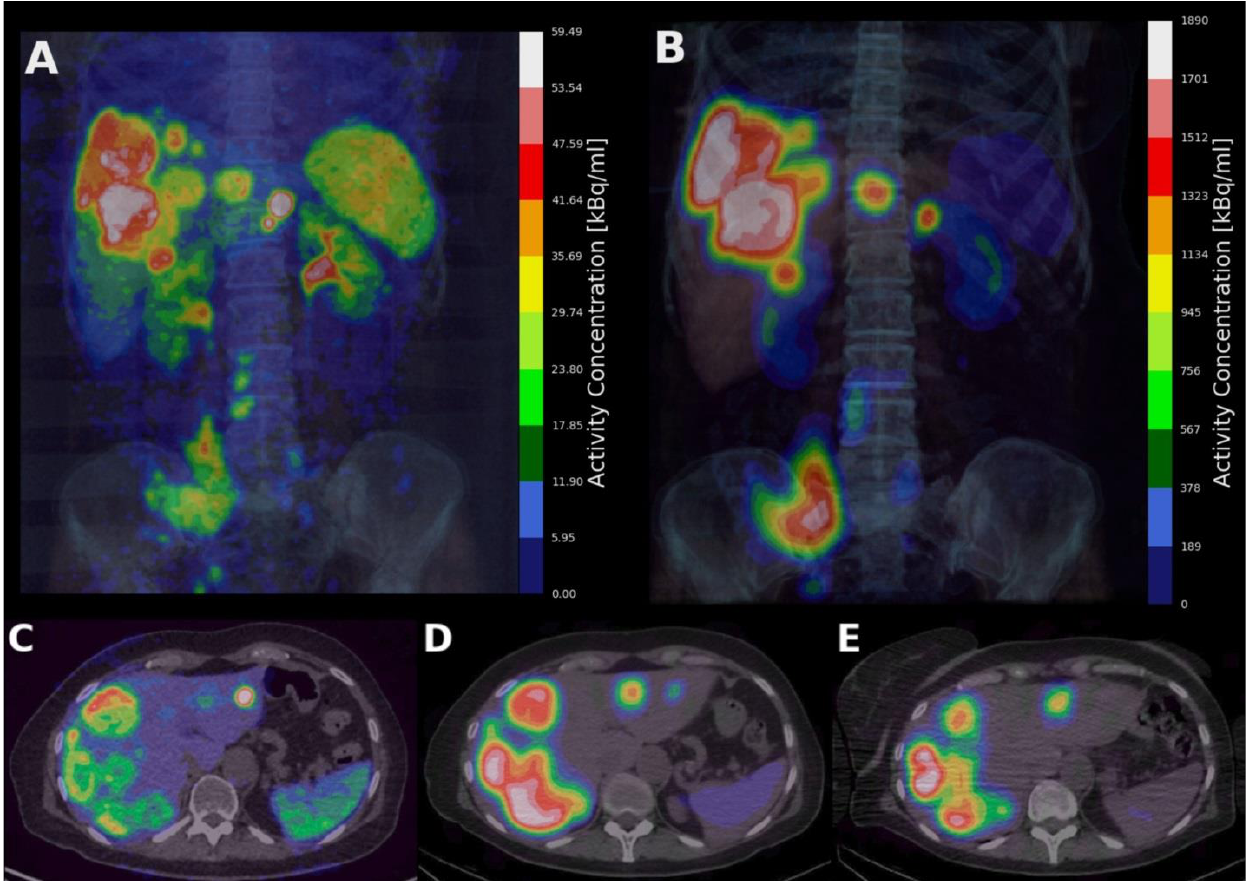
Figure 1. Maximum intensity projection (MIP) of a [ 68 Ga]Ga-DOTA-TOC PET/CT image ( A ); and corresponding [ 177 Lu]Lu-DOTA-TATE SPECT/CT image at the 24 h p.i. timepoint ( B ); axial slices of [ 68 Ga]Ga-DOTA-TOC ( C ); and [ 177 Lu]Lu-DOTA-TATE at t 24 ( D ); and t 168 ( E ), showing uptake in SSTR-expressing tumours. Physiologic uptake in kidneys, spleen and liver is also visible. [ 177 Lu]Lu-DOTA-TATE SPECT/CT imaging (example in Figure 1B,D,E) was on